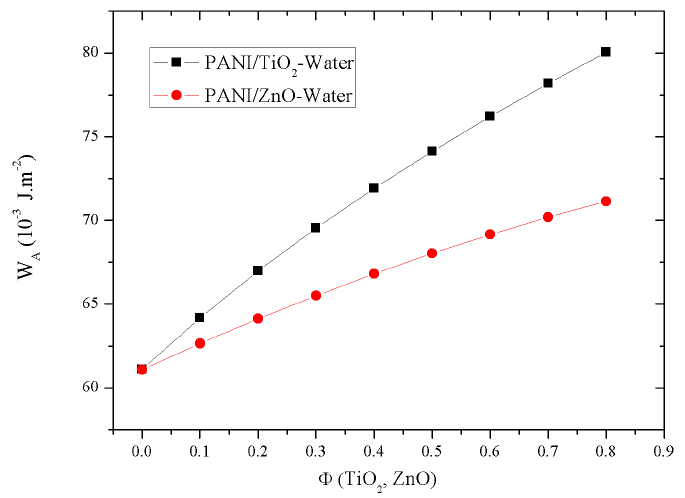
Figure 6. Work of adhesion of PANI/TiO 2 and PANI/ZnO as a function of the volume fraction Φ of NPs.